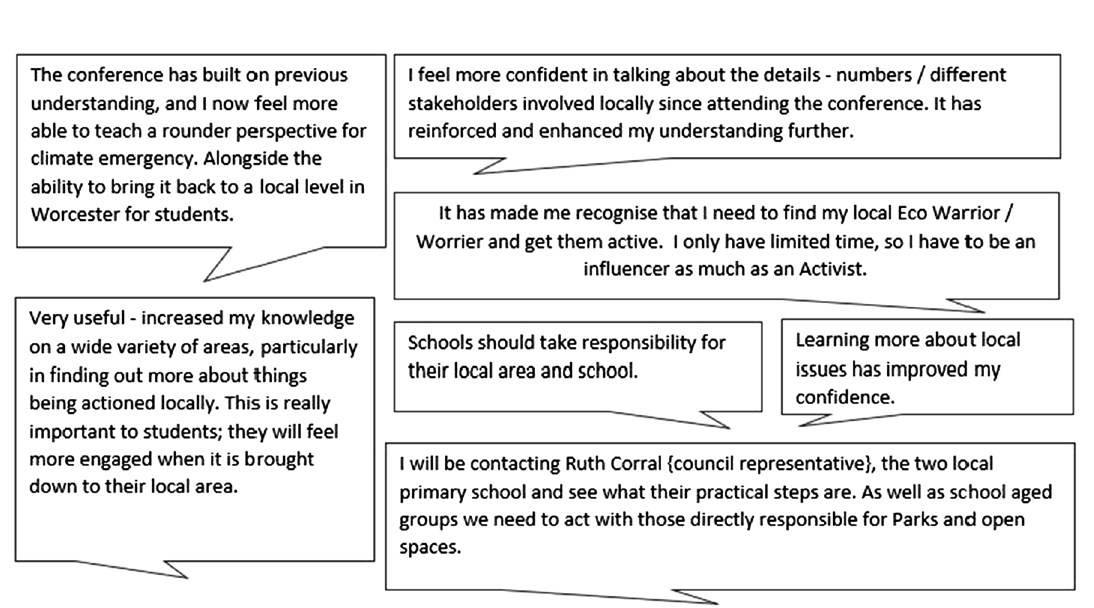
Fig. 7 Comments linked to a local